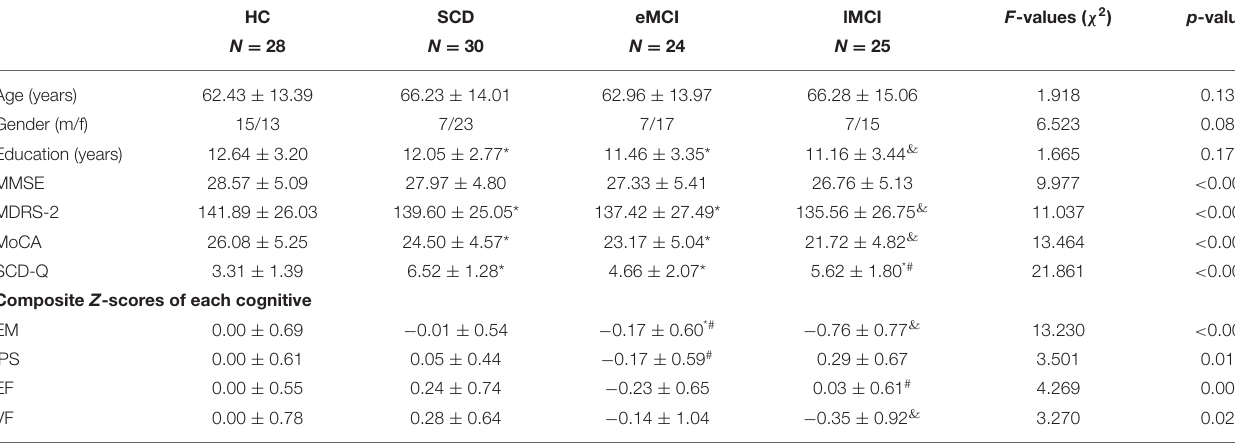
TABLE 1 | Demographics and clinical measures of HC and patients with SCD, eMCI, and